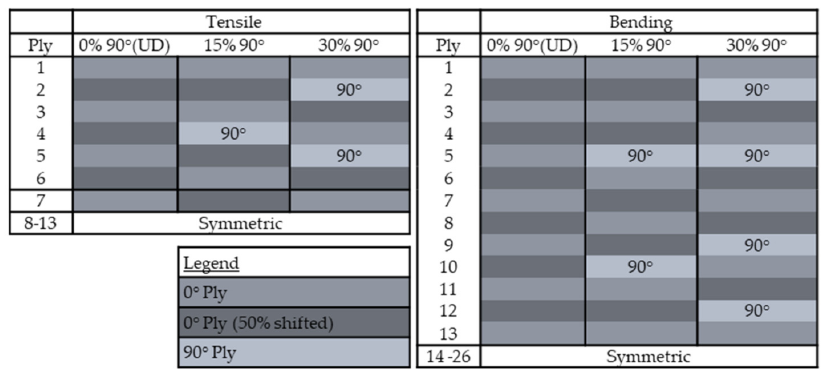
Figure 9. Ply configurations for the specimens for tensile and bending